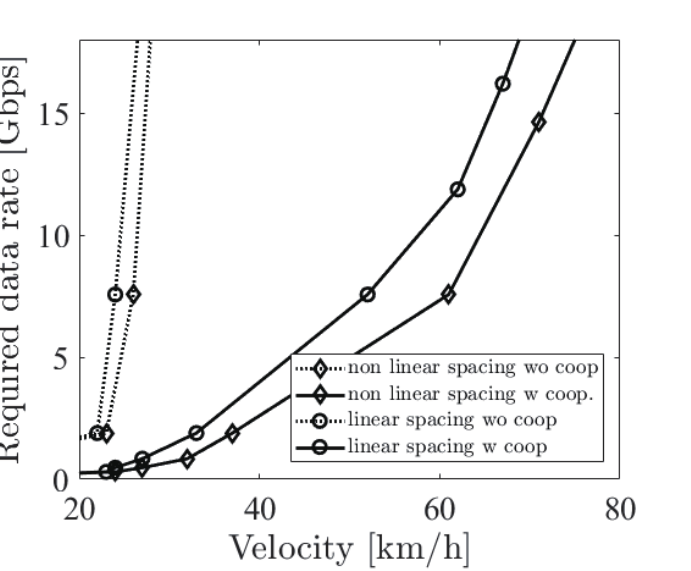
Figure 12. The required sensor data rate with the options of a linear and a non-linear spacing LiDAR sensor at d be = 10